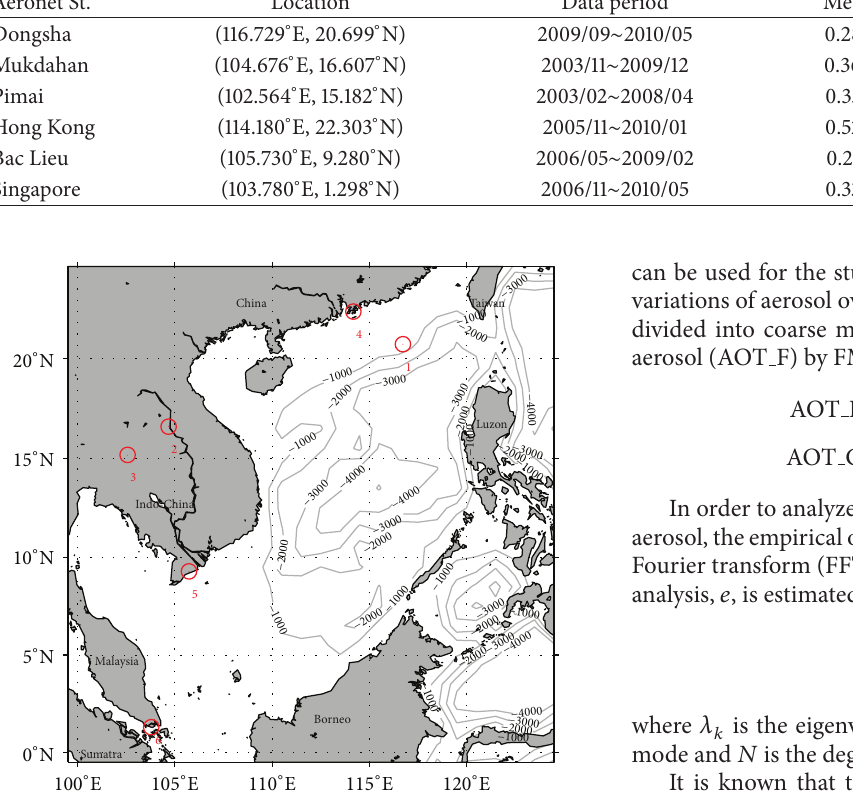
Figure 1: A map of SCS with isobaths. The circle represents Aeronet observation station, 1: Dongsha, 2: Mukdahan, 3: Pimai, 4: Hong Kong, 5: Bac Lieu, and 6: